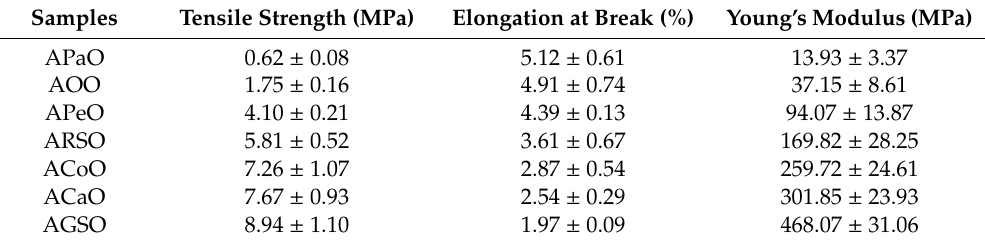
Figure 5. Stress–strain curves of the UV-cured films. Table 4. Mechanical properties of the UV-cured films.